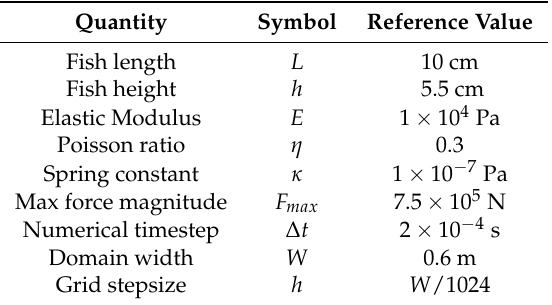
Table 1. Parameters used in